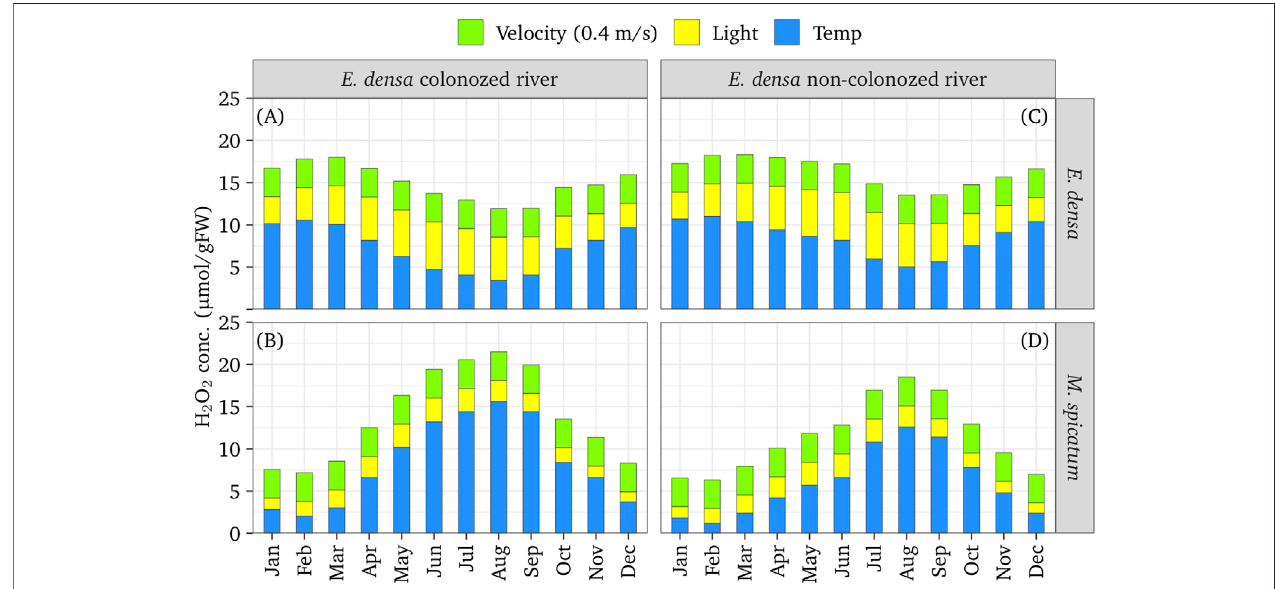
FIGURE 10| Simulated annual H 2 O 2 component generated by each environmental component ofa 0.4 m deep colonized [ (A,C) for E.densa and M. spicatum ] or non-colonized [ (B,D) for E. densa and M. spicatum ] rivers.